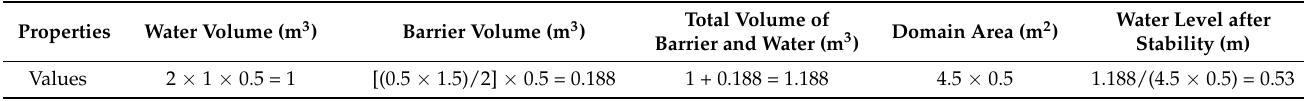
Table 1. Analytical solution and water level after